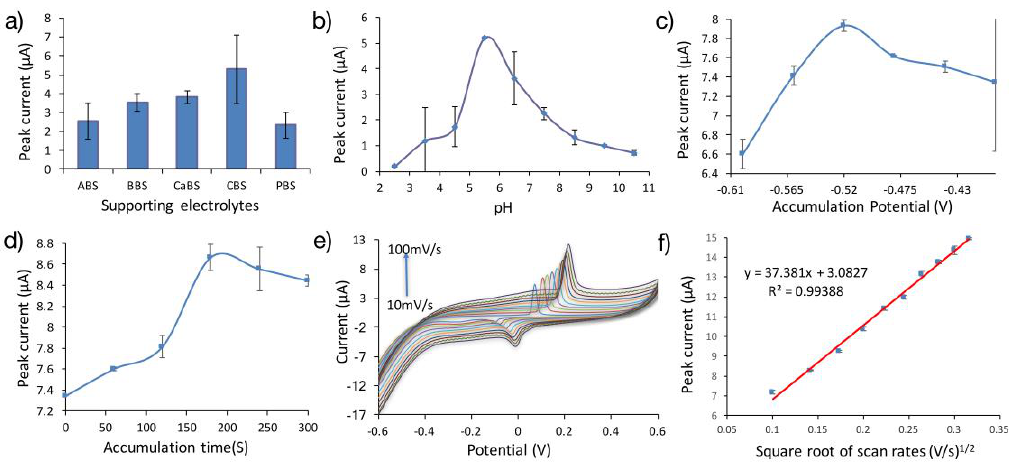
Figure 4. Effect of supporting electrolytes ( a ), pH ( b ), accumulation potential ( c ), and accumulation time ( d ) on the oxidation peak current of 10 μM quinoline. ( e ) Cyclic voltammograms of 10 μM quinoline in 0.2 M CBS (pH 5.5) at BL4/SPCE at various scan rates. ( f ) The relationship of the oxidation peak current (Ipa) and the square root scan rates (v 1/2 )